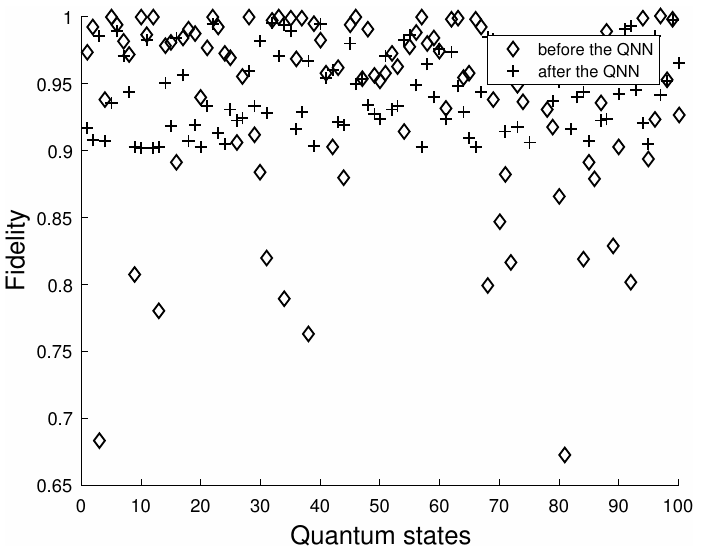
Figure 7. The fidelity of quantum states before and after training the QNN on the quantum state of the second part.